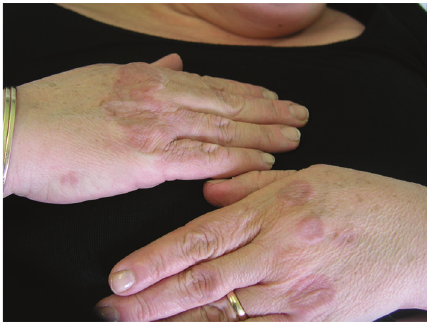
Figure 1: Woman with annular arrangement of erythematous and flesh-coloured papules at her hands.